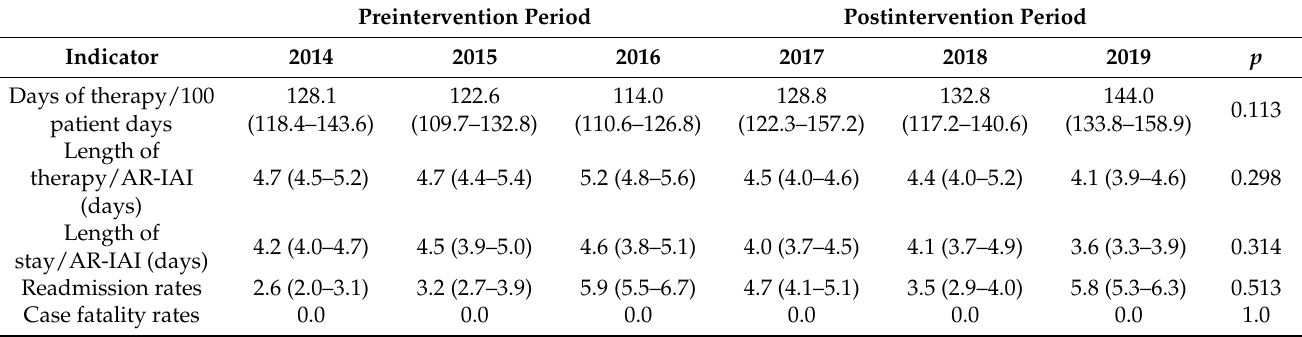
Table 1. Antimicrobial use (AU), both as days of therapy/100 patient days and as length of therapy (in days), and length of stay (in days) expressed as median (IQR) of monthly results; readmission rates and case fatality rates expressed as percentages (CI95%), totalled for each year for better data visualisation in appendix-related intraabdominal infections (AR-IAI) during the study period. Changes were assessed using interrupted time series analysis (step change